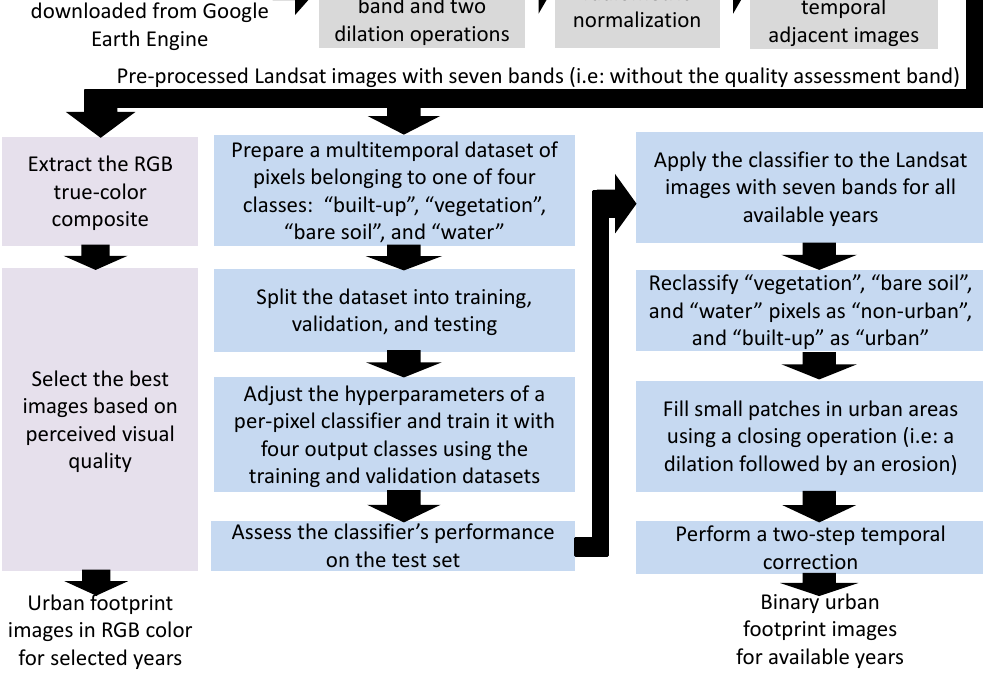
Figure 3. Flow diagram with the pre-processing of Landsat images. There are three main stages highlighted in distinct colors in the diagram. The first stage removes clouds and NoData values and applies the result to the other two stages in parallel. The second stage extracts the urban footprint in RGB color for selected years. The third stage uses classification processes and morphological operations to obtain the binary urban footprint for available